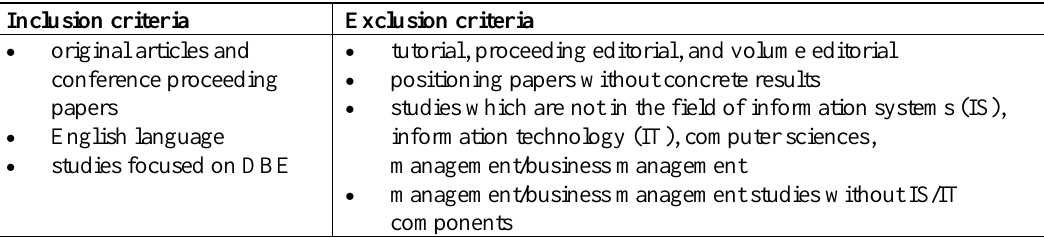
Table 4. Selection criteria used for the screening process